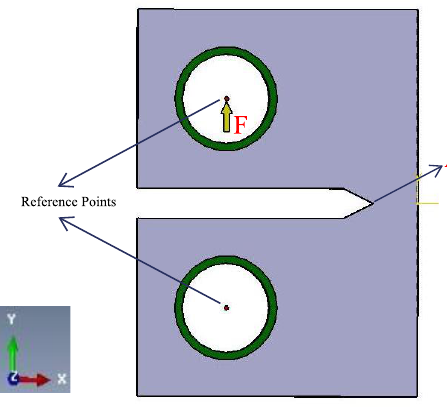
Figure 2. Boundary conditions of CT-Test.